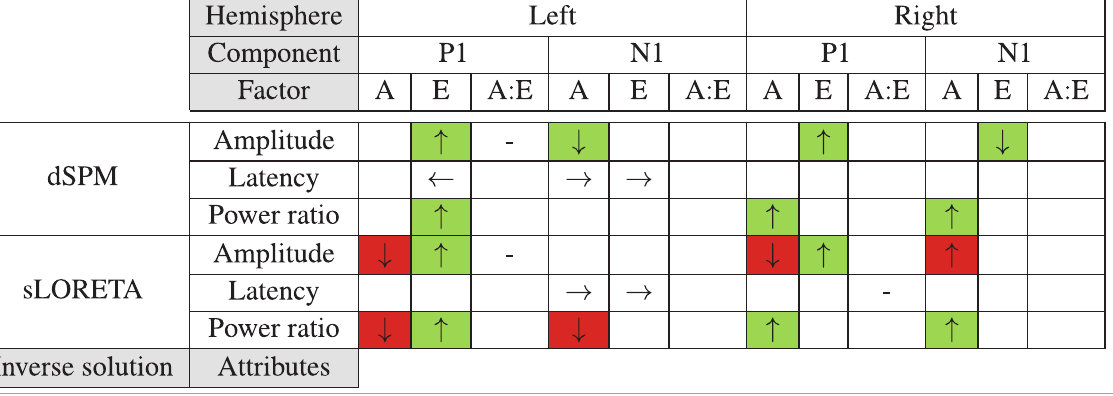
TABLE 1 Summary of the effects of anatomy (A) and electrode locations (E) as well as their interaction (A:E) resulting from the statistical tests.